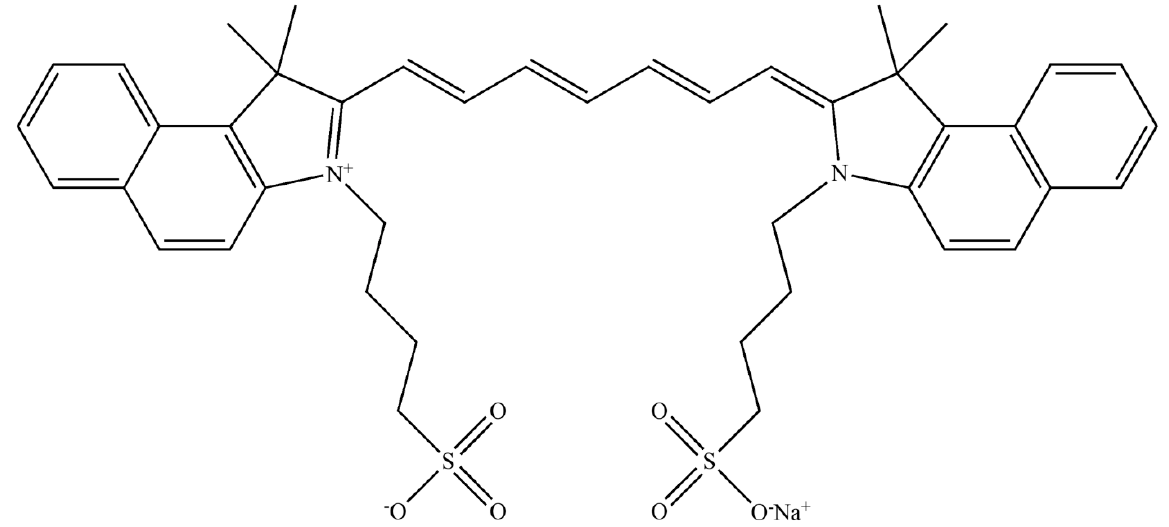
Figure 1. Chemical structure of indocyanine green dye.